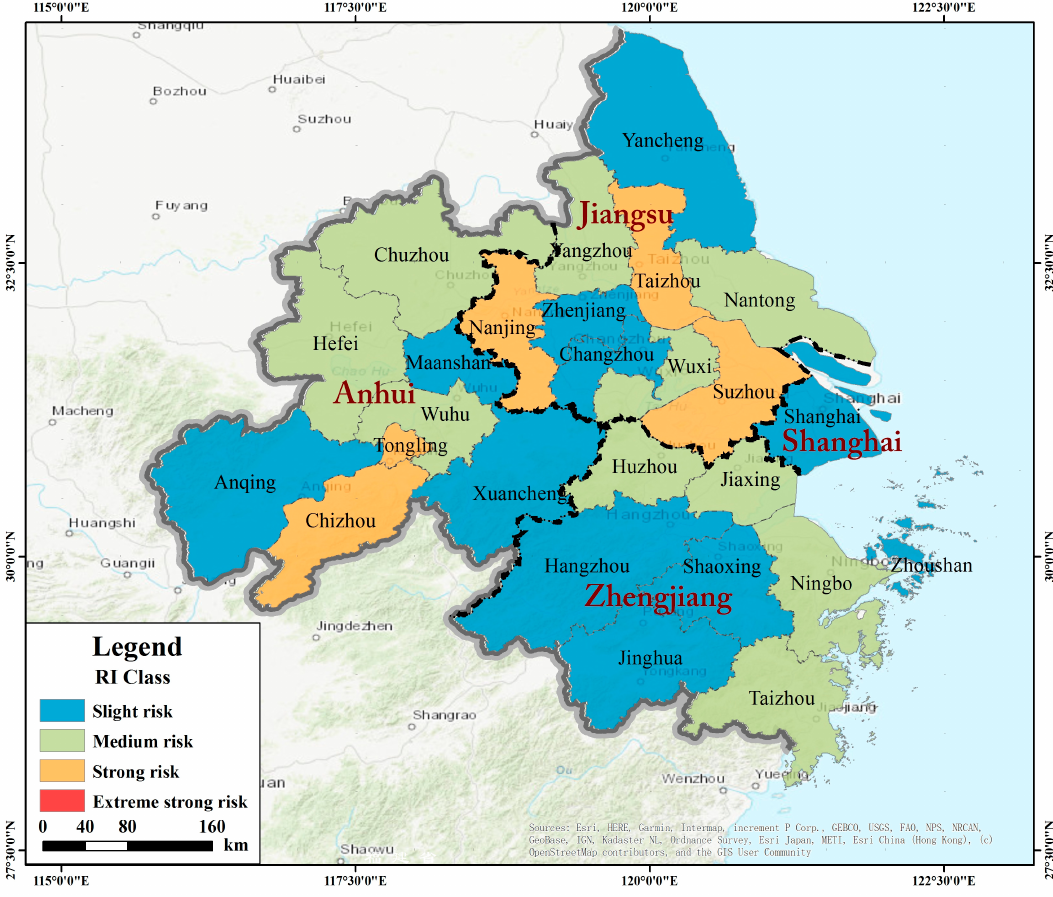
Figure 5. Ecological risk levels of potentially toxic elements (PTEs) in the cities of the Yangtze River Delta (YRD).